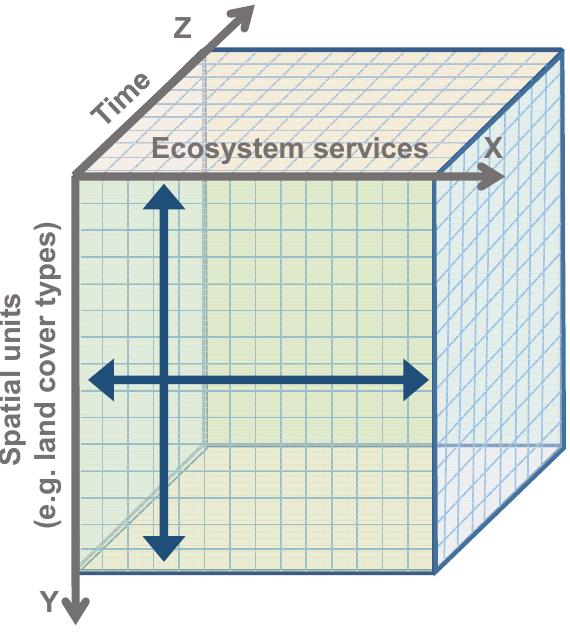
Figure 9: Integration of temporal aspects into the matrix by including a third dimension (3D-Matrix) and horizontal (within spatial units) as well as vertical (within ecosystem service types) cross-comparisons of assessment values.